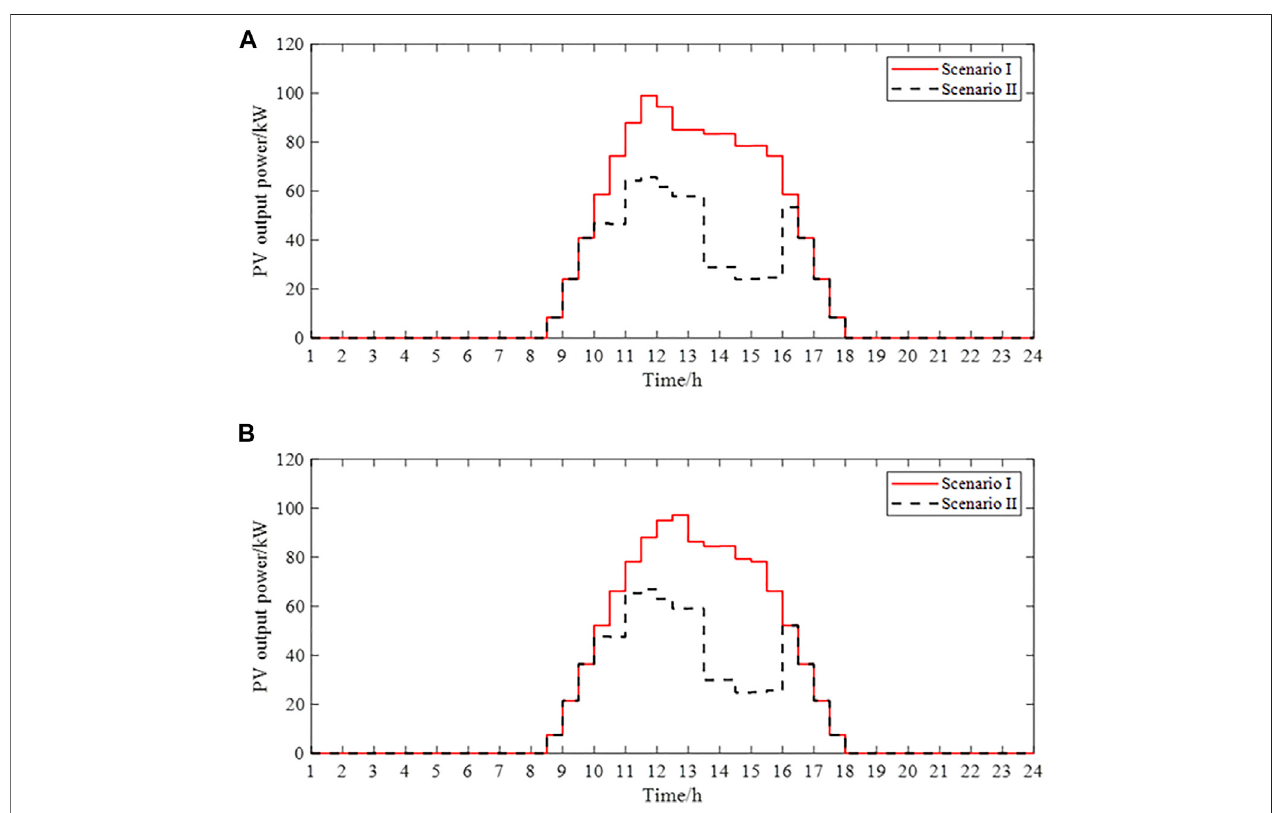
FIGURE11| CorrespondingPVoutputpowerwhentheoptimalschedulingresultsare f opt- and f opt+ . (A) PVoutputpowerwhentheoptimalschedulingresultis f opt- . (B) PV output power when the optimal scheduling result is f opt+ .